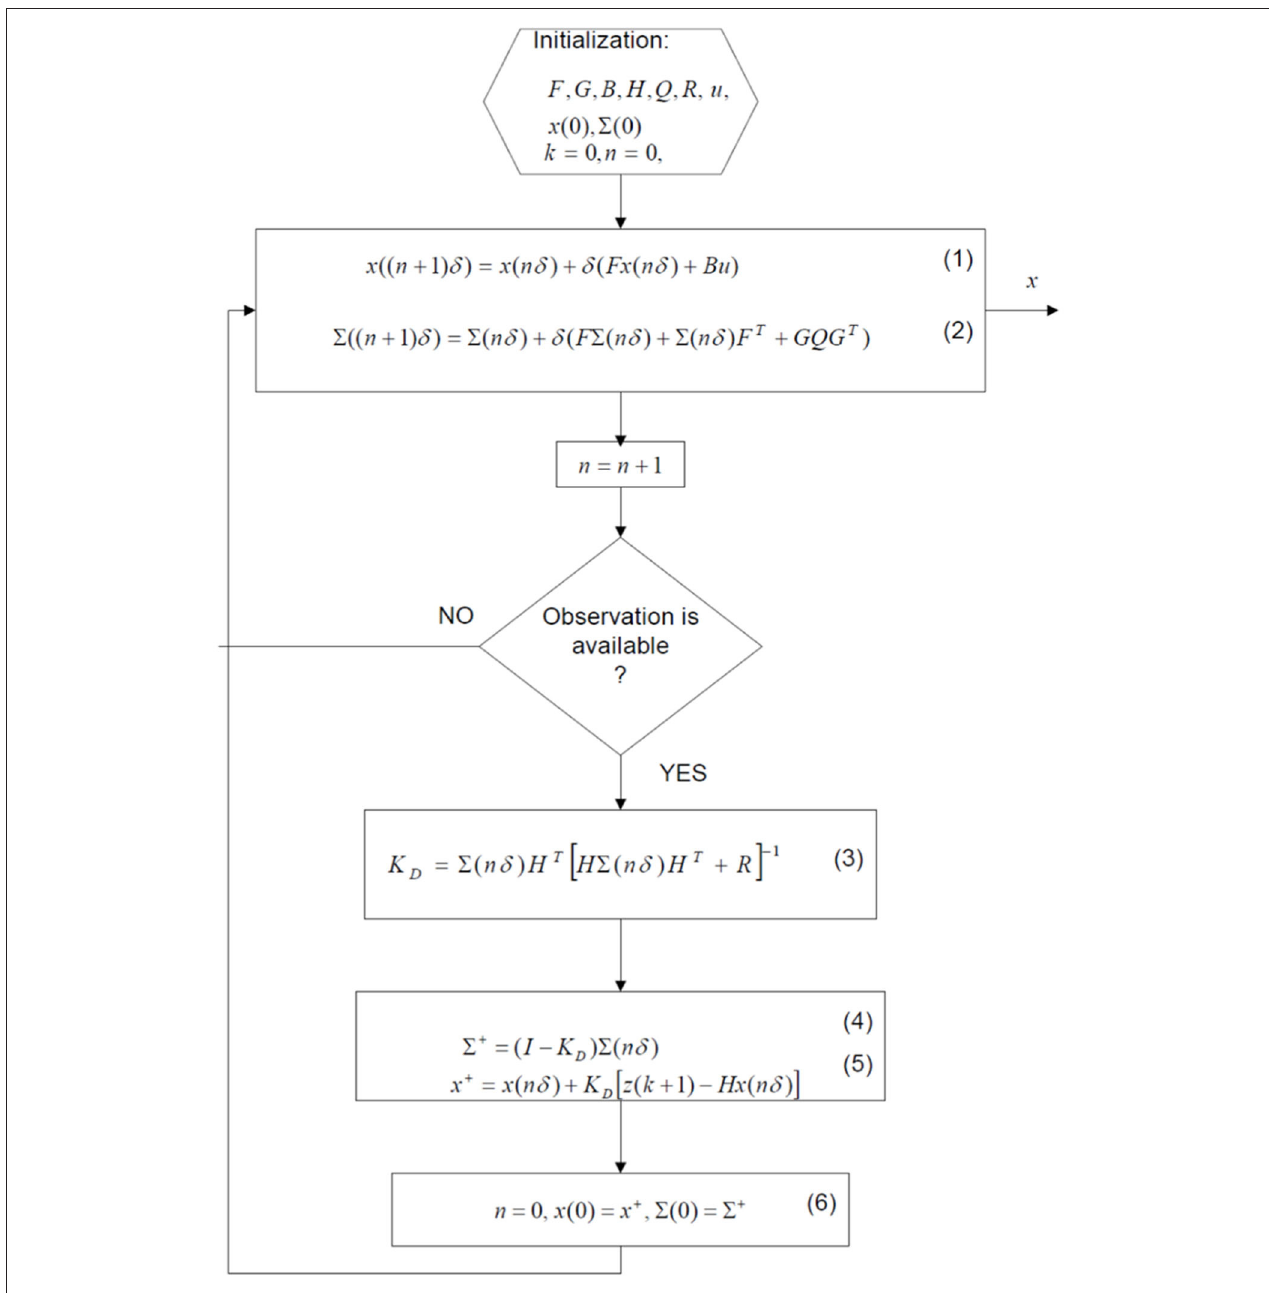
FIGURE 3 | The algorithm